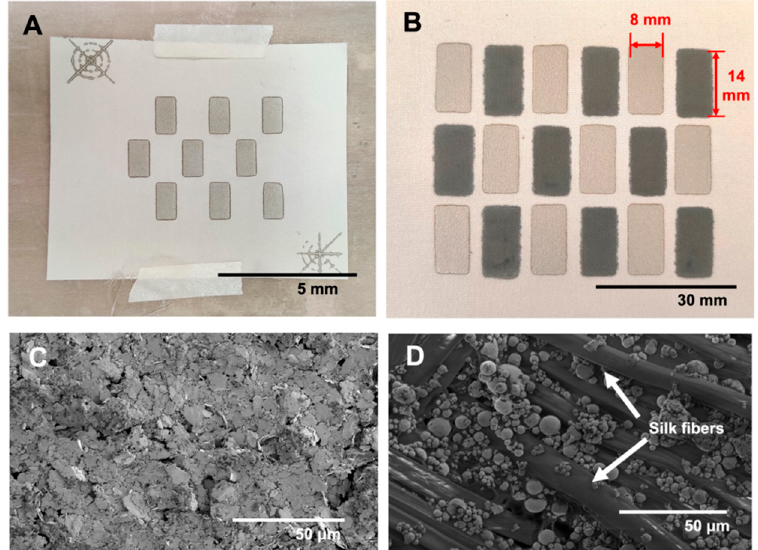
Figure 1. ( A ) The resulting Ag/AgCl electrodes. ( B ) The resulting cured Ag/AgCl and Zn electrodes. The nominal electrode dimensions are seen in the figure. ( C ) Scanning electron microscopy (SEM) image to show the microstructure of printed and cured Ag/AgCl cathode. ( D ) SEM image to show the microstructure of printed and cured Zn anode with the underlying silk